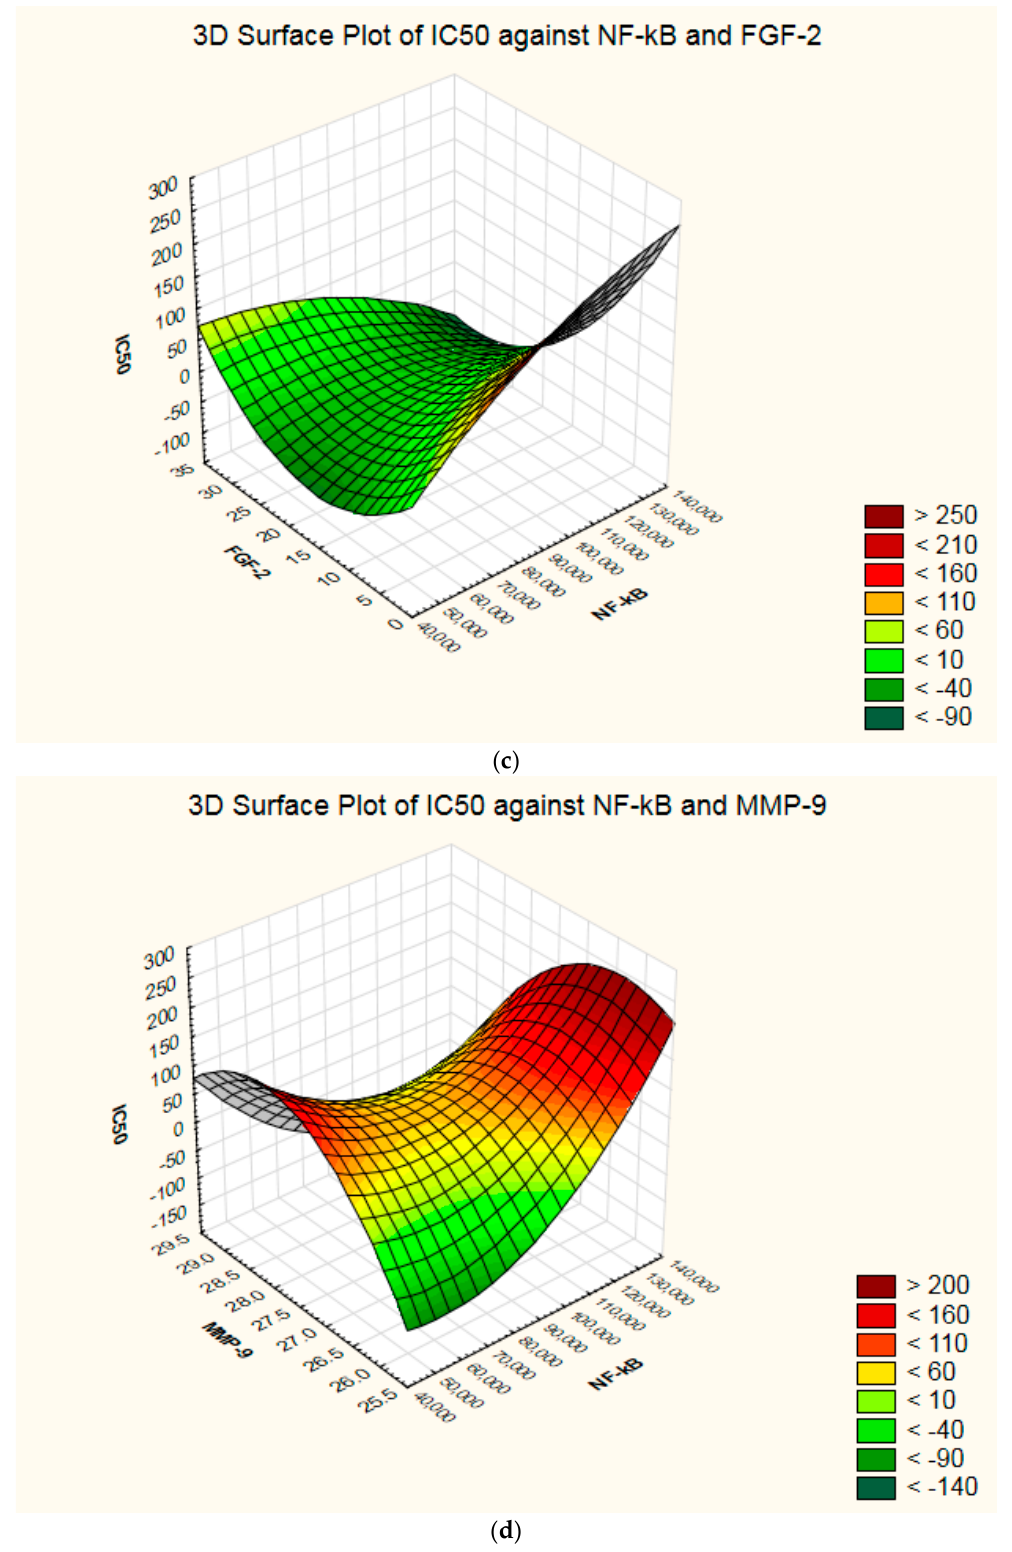
Figure 6. Tridimensional surface plots depicting the covariance between NF- κ B, FGF-2, MMP-9 levels, and IC 50 values in treated A2780 cells. a − 3D Surface Plot of NF- κ B against FGF-2 and MMP-9; b − 3D Surface Plot of MMP-9 against NF- κ B and FGF-2; c − 3D Surface Plot of IC 50 against NF- κ B and FGF-2; d − 3D Surface Plot of IC 50 against NF- κ B and MMP-9.